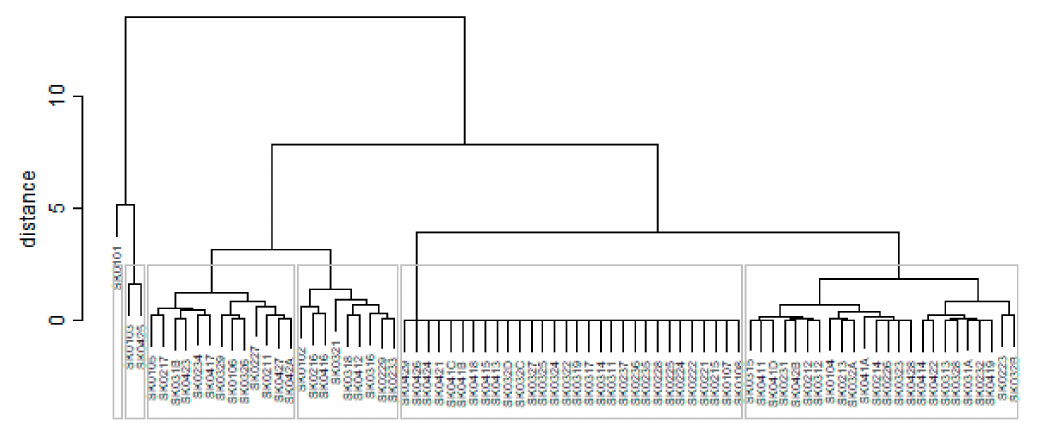
Figure 3. Medical equipment heat map of the districts in the year 2015. Source: own elaboration by the